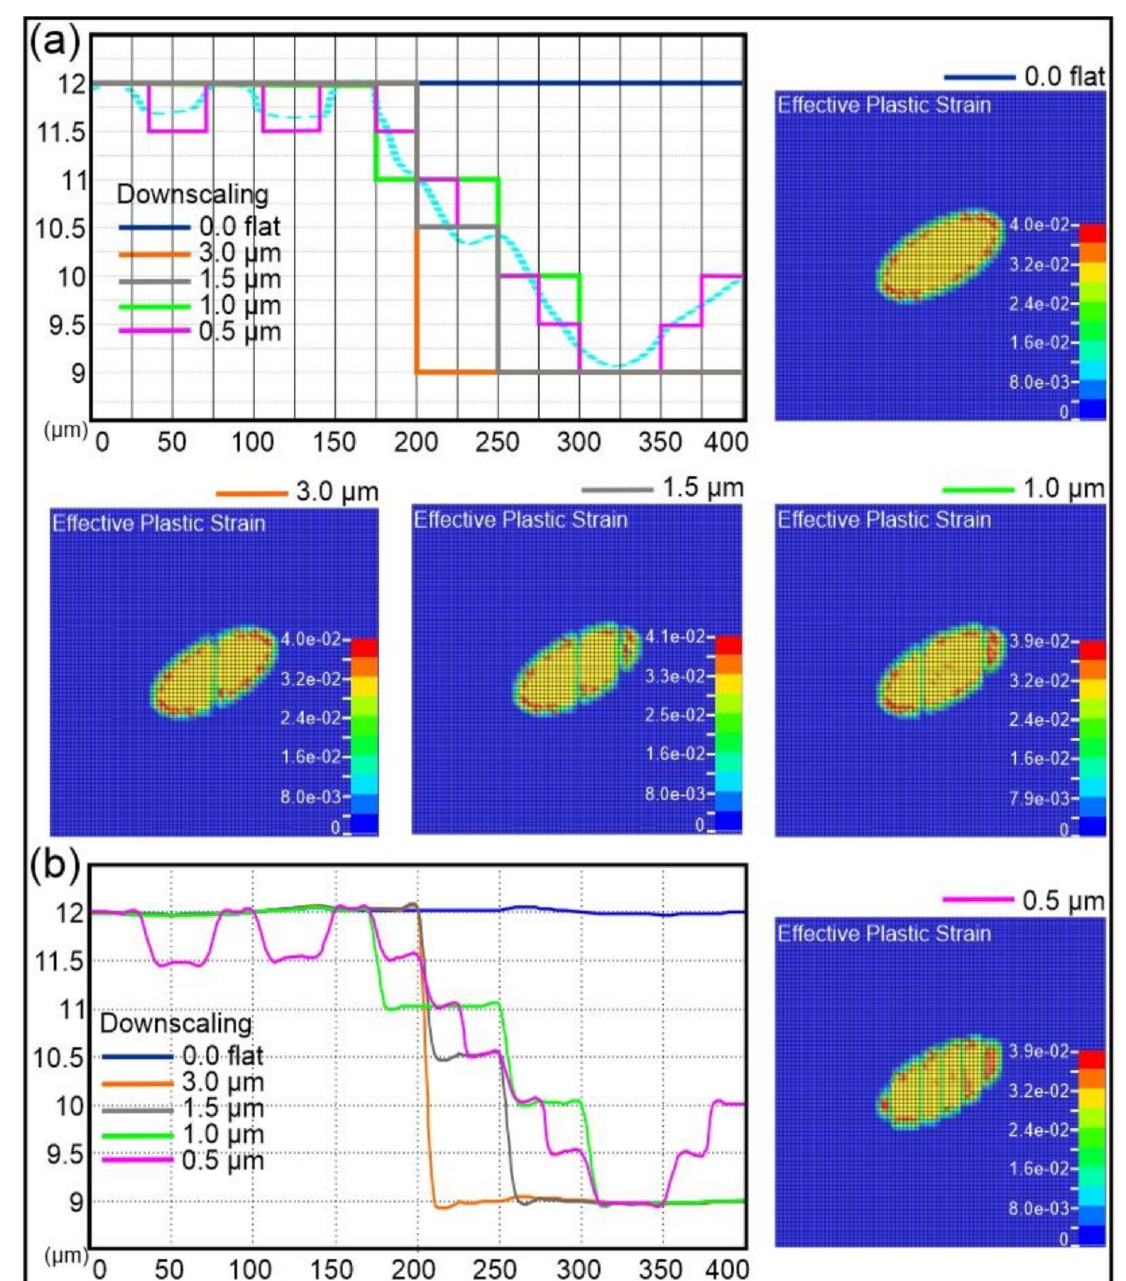
Figure 3. Downscaling for surface roughness from 0 to 0.5 µ m. The computed nodal positions and the plastic strains 100 ns after the laser beam irradiation are presented. ( a ) A step-like linear approximation of the roughness profile is shown and the original flat surface was gradually downscaled to reach the resulting roughness curve (dashed, cyan line) after the Gaussian filtering. ( b ) The permanent nodal positions on the top surface along the central horizontal x -axis 100 ns after the laser beam